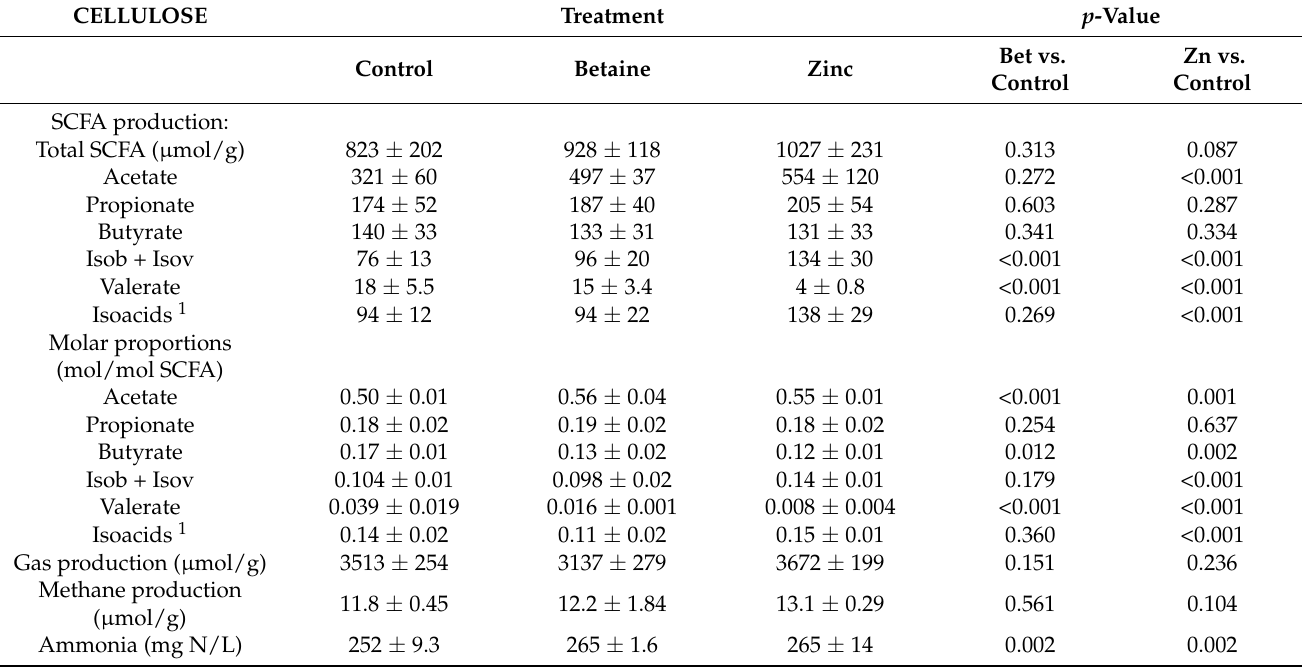
Table 4. Production of SCFA, molar proportions of SCFA, gas and methane production, and ammonia concentration after 24 h of the in vitro fermentation of cellulose by fecal inocula obtained from pigs under heat stress conditions and fed diets supplemented or not with betaine (5 g/kg) or zinc (0.120 g/kg). Means ± standard deviations are